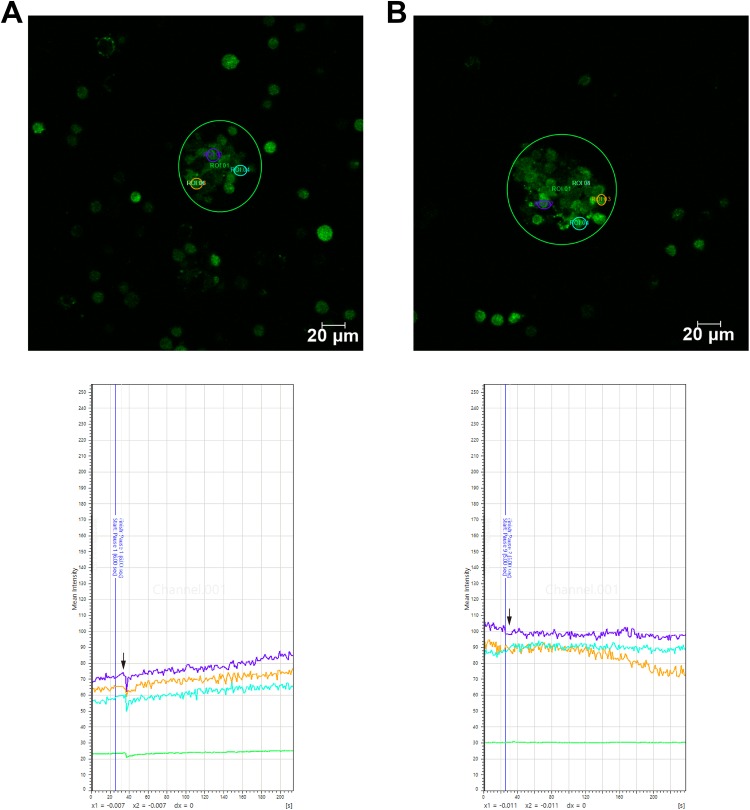
Calcium imaging of neural stem cells. Representative fields and curve graphs (the
intensity of green fluorescence represents the relative level of intracellular
Ca2+) of calcium-dye-loaded neurospheres (A) with or (B) without
voltage-gated calcium ion channel-specific inhibitor nifedipine (arrows show rTMS
treatment was applied), showing that rTMS treatment upregulated intracellular
Ca2+ levels and could be blocked by nifedipine.